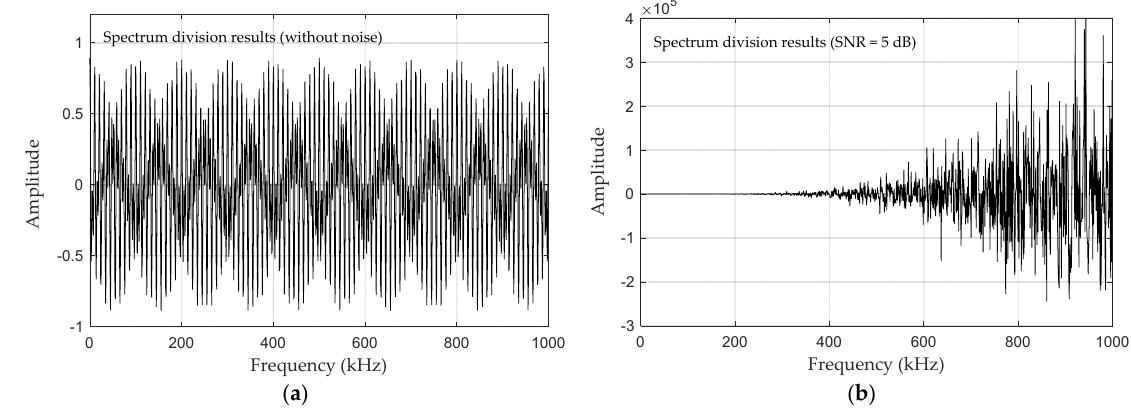
Figure 6. Results of spectrum division under two conditions: ( a ) spectrum-division results without noise; ( b ) spectrum-division results with SNR = 5 dB.